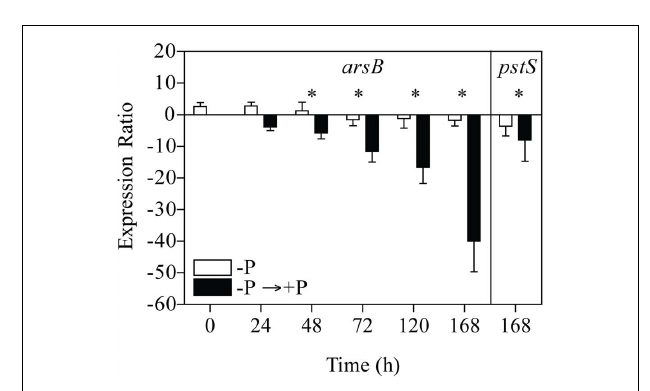
FIGURE 7 | Expression patterns for arsB and pstS in phosphate deficient cultures ( − P) re-fed with phosphate ( + P). The expression ratio is the fold change of triplicate measurements between the sample expression and the calibrator expression (e.g., the zero time point). Error bars indicate the SE of triplicate measurements of the expression ratio. Significance ( p < 0.05) is indicated (*) for the − P versus the re-fed culture at a single time point for pair-wise fixed reallocation randomization